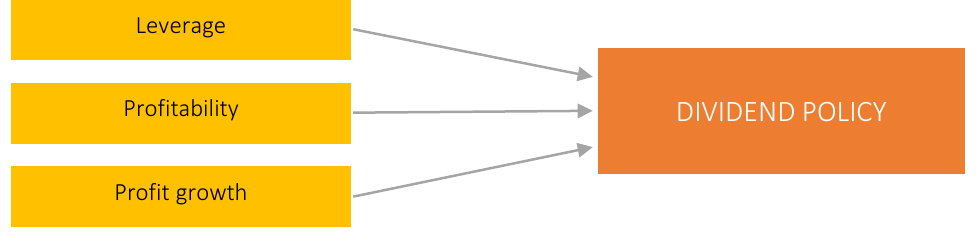
Figure 1. The conceptual